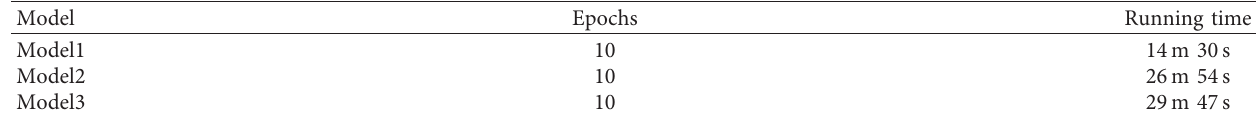
Table 5: Comparison of training time of